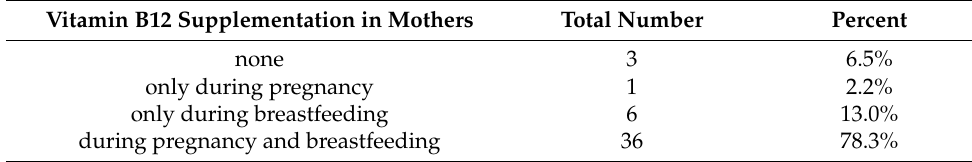
Table 10. Supplementation of vitamin B12 in mothers during pregnancy and breastfeeding.